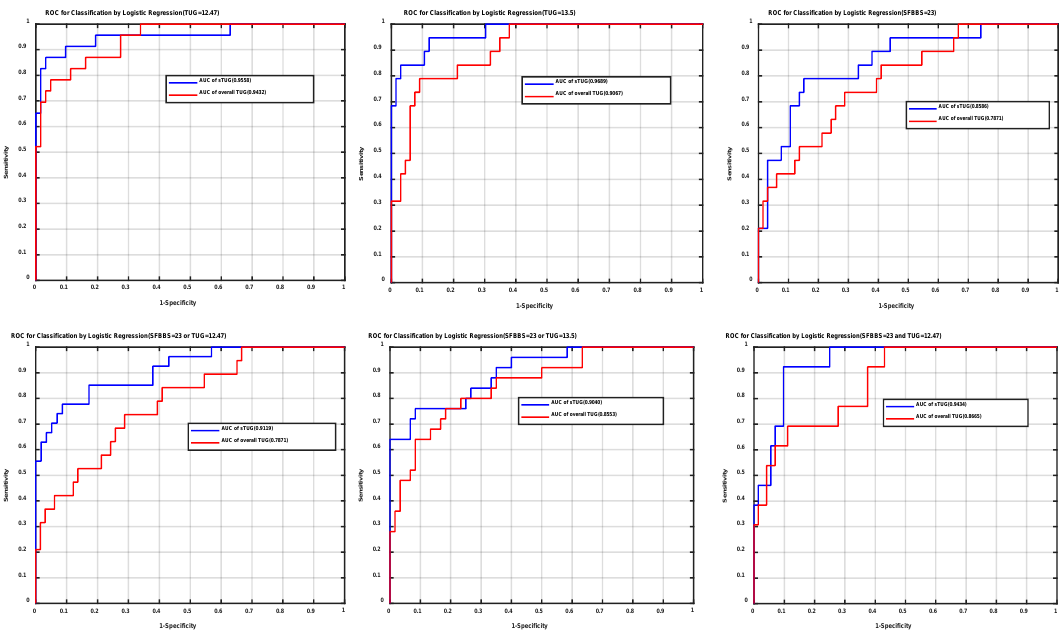
Figure 6. ROC for classification by logistic regression for the clinical test and TUG segmentation.